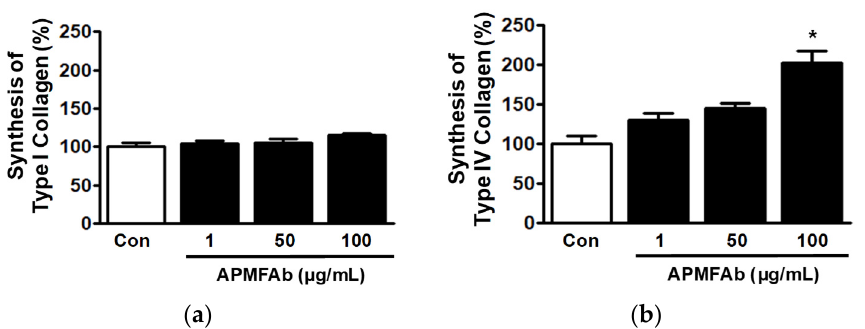
Figure 4. Effects of Angelica polymorpha Maxim. flower absolute on the syntheses of type I and IV collagens. HaCaT cells were incubated in the absence or presence of APMFAb (1–100 μ g/mL) for 48 h. Conditioned media were subjected to sandwich ELISA using anti-type I ( n = 3; a ) or anti-type IV collagen antibody ( n = 3; b ). Collagen levels in conditioned media are expressed as percentages of those in non-treated controls (Con). Results are presented as means ± SEMs. * p < 0.05 vs. non-treated cells.